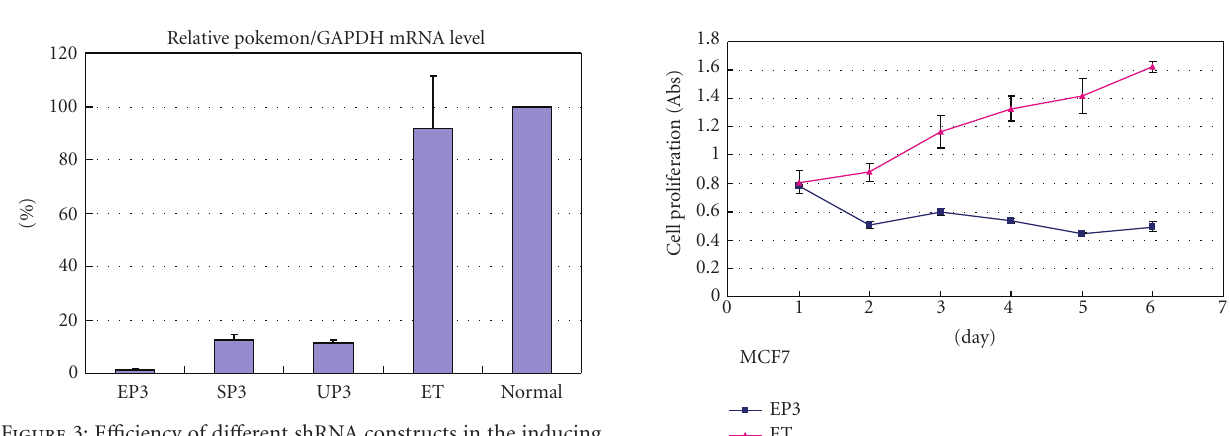
Figure 3: E ffi ciency of di ff erent shRNA constructs in the inducing of silencing on Pokemon/GAPDH mRNA level as quantified by real-time RT-PCR. Total RNA was extracted from MCF-7 cells 36 hours after transfection with the indicated constructs. Normal MCF-7 cells were used as a negative control. An external standard curve was created to make sure that Pokemon and GAPDH were amplified at similar e ffi ciency. Data shown represents, three replicated experiments with error bar indicated.